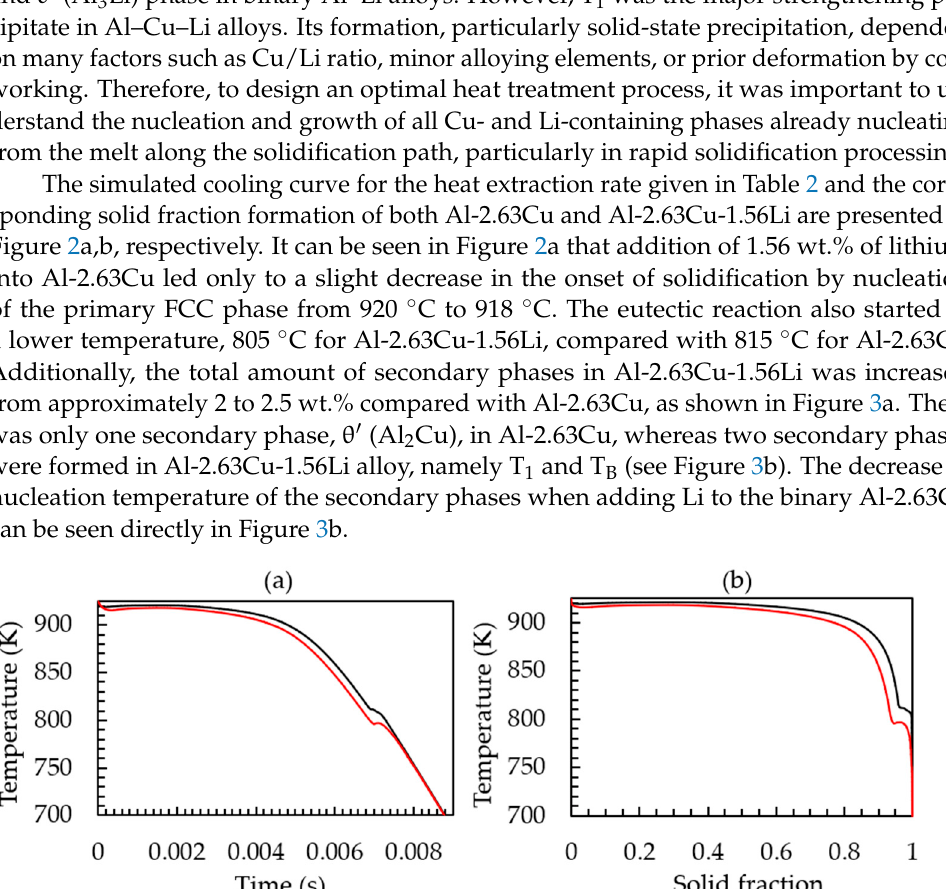
Figure 3. ( a ) Temperature versus total second phase fraction; ( b ) amount of θʹ , T 1 , and T B fraction versus time of Al ‐ 2.63Cu and Al ‐ 2.63Cu ‐ 1.56Li droplet solidification. Huang and Zheng [9] reported that for conventional casting with additional aging treatment, θʹ phase formation is observed to be less frequent in the range of Li concentra ‐ tion from 0.5 wt.% to 1.6 wt.% and is entirely suppressed at a high Li level of 1.6 wt.%. In order to verify the effect of lithium concentration on secondary phase formation during rapid solidification, Scheil calculations were carried out, and the results are presented in Figure 4. According to the Scheil results, it may be concluded that θʹ formation can be expected when the lithium content is lower than 0.5 wt.%; above this, the θʹ formation is compensated by T B and T 1 formation during rapid solidification.